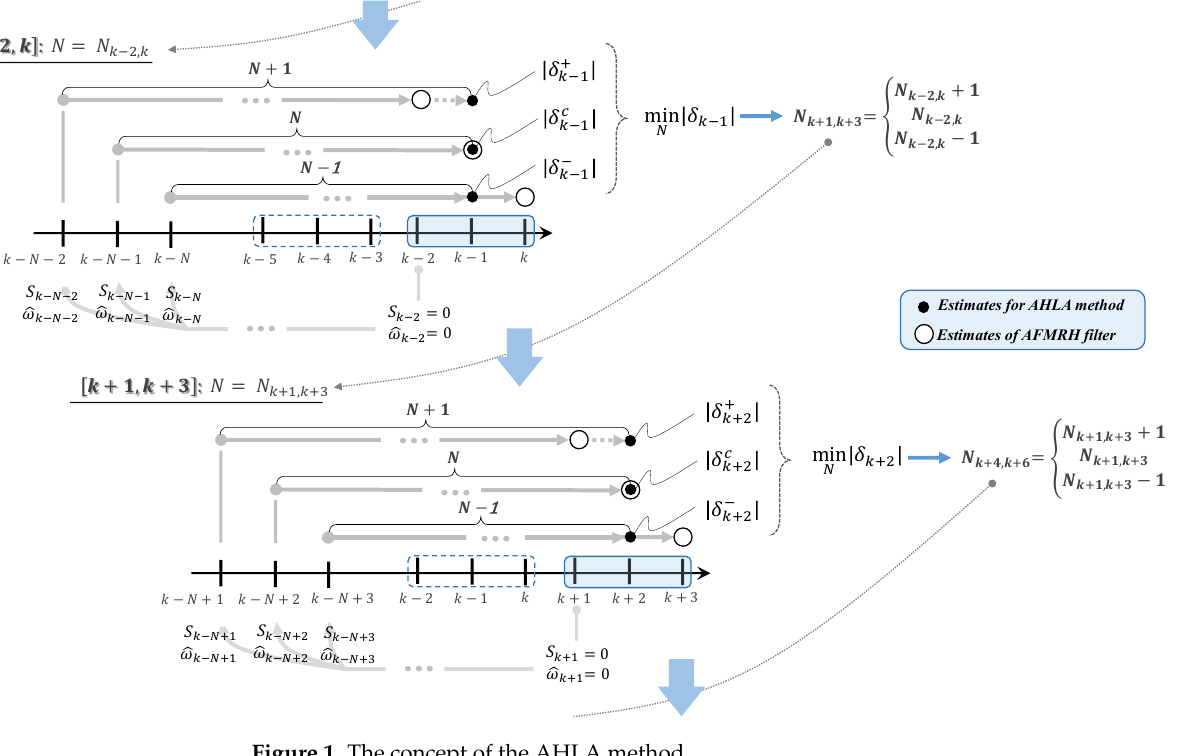
Figure 1. The concept of the AHLA